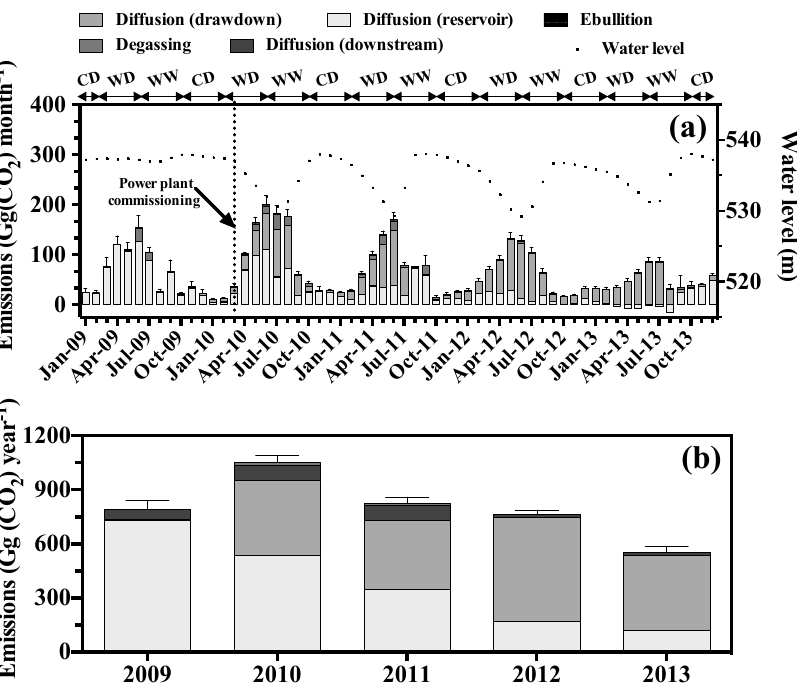
Figure 8. Monthly (a) and yearly (b) average of the total emissions from the Nam Theun 2 Reservoir by diffusion at the reservoir surface, diffusion from the drawdown area, ebullition, degassing and diffusion from the Nam Theun River and artificial channel at the Nam Theun 2 Reservoir (Lao PDR). In panel (a) , water-level variations in the reservoir are also